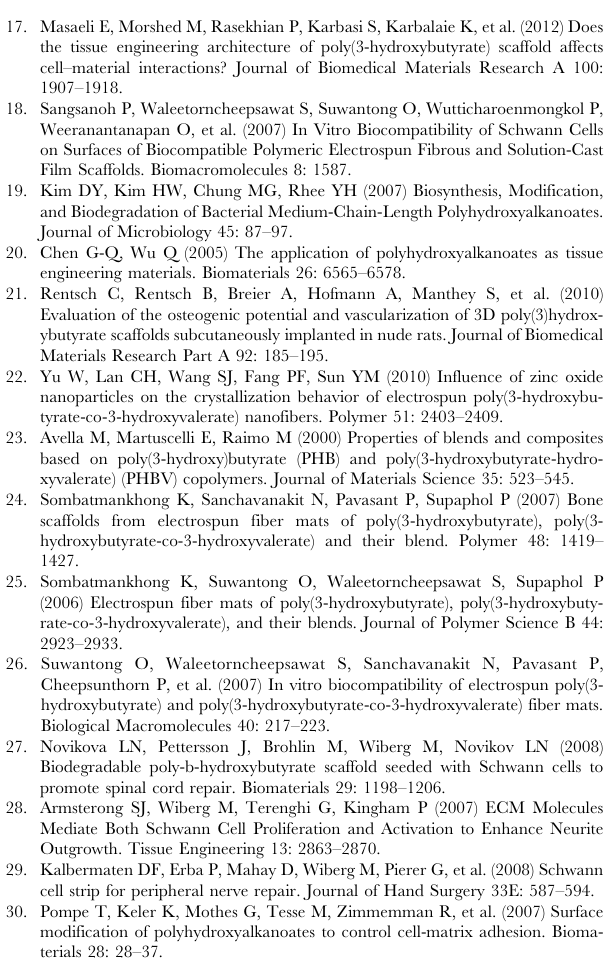
Figure S4 Metabolic activity and proliferation of SCs on different PHB/PHBV electrospun solution blending nanofibrous scaffolds during 14 days of culture. (A) alamar blue assay; (B) DNA quantification assay. Asterisks represent significant difference at p # 0.05. (TIF) Table S1 The designed primers of genes for real-time PCR. Table S2 Raman shift (cm 2 1 ) and assignment of the Raman bands of PHB/PHBV